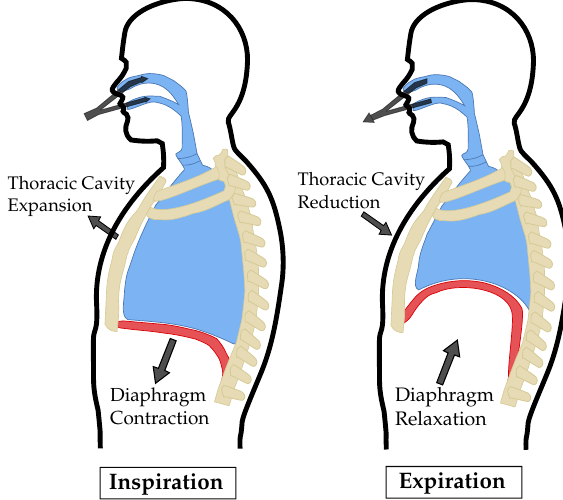
Figure 2. Simplified illustration of the physical motion during inspiration and expiration